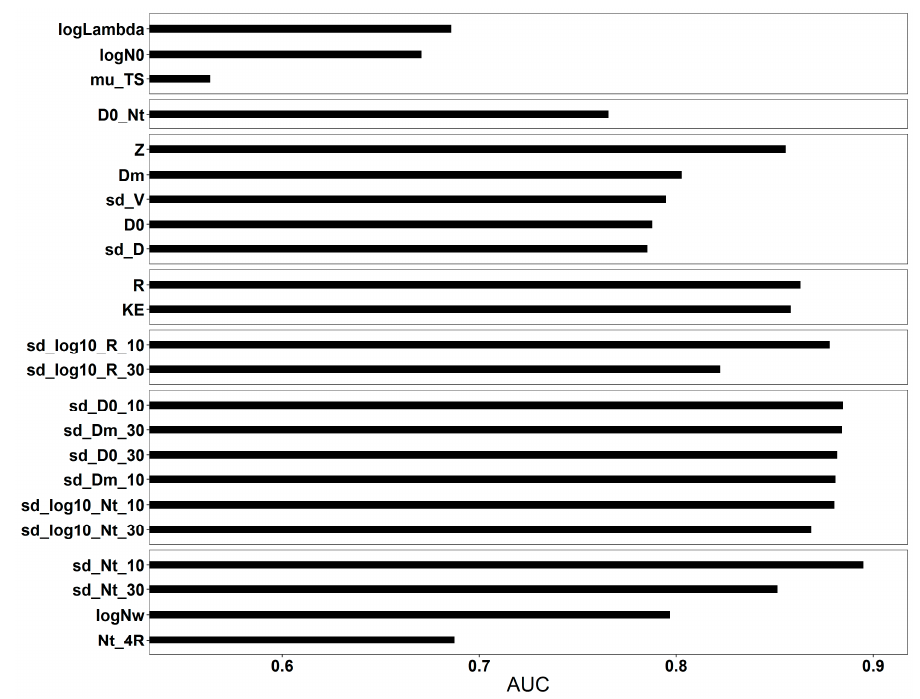
Figure 5. Relative importance of the rain microstructure parameters expressed by the area under the receiver operating characteristic curve (AUC) [67].